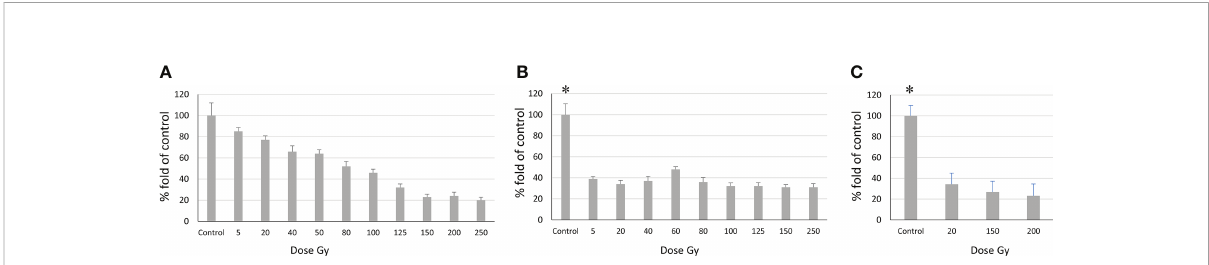
FIGURE 5 Relationship between the number of proliferating cells and radiation dose according to the MTT assay. (A) Sus\fP2 cells; (B) GO1 cells, (C) Sus \fP2 cells exposed to radiation below 5 G g . Each value is the mean of ≥ 3 independent experiments ± Standard Error of the Mean (SEM). Control values on (B, C) (denoted with *) signi fi cantly exceeded the experimental ones at any radiation doses with p<0.01 according to the Mann- Whitney test.